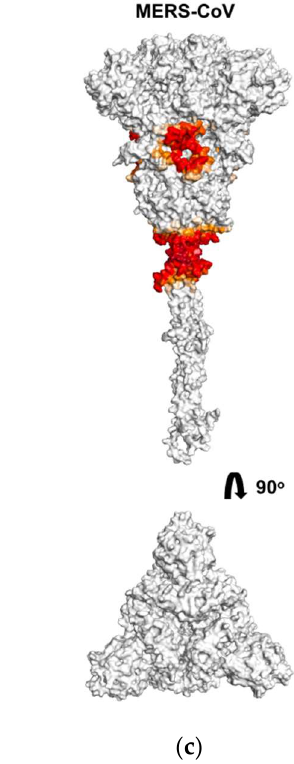
Figure 2. Molecular surfaces of coronavirus spike proteins of SARS-CoV ( a ), SARS-CoV-2 ( b ), and MERS-CoV ( c ) with depicted areas of Zn-PcChol 8+ binding in the lateral view (upper panels) and in the top view (lower panels). The regions of PS interactions with S-protein surface are colored by gradient from orange to red in dependence of contact probability.